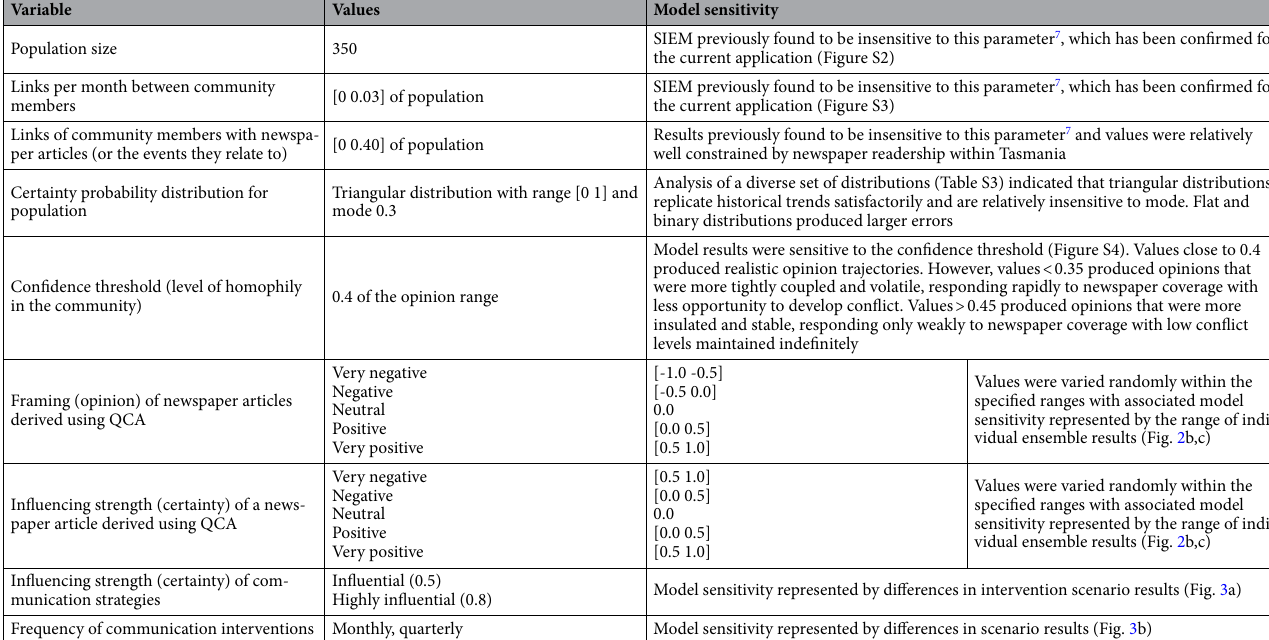
Table 1. Model parameters and strategies for capturing parameter uncertainty. Where a range is indicated, values were assigned randomly at each time-step during the model run. For example, newspaper articles